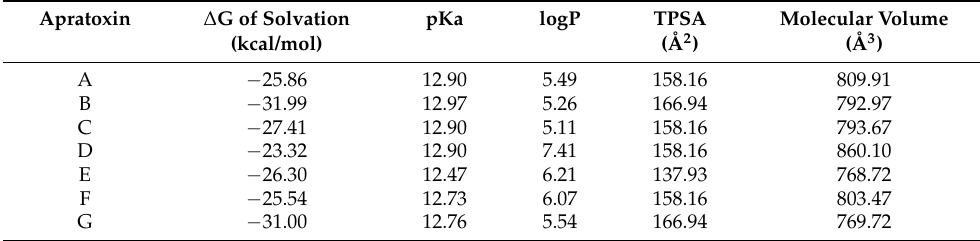
Table 3. Predicted pharmacokinetic parameters of the Apratoxins A–G family of marine cyclopeptides.